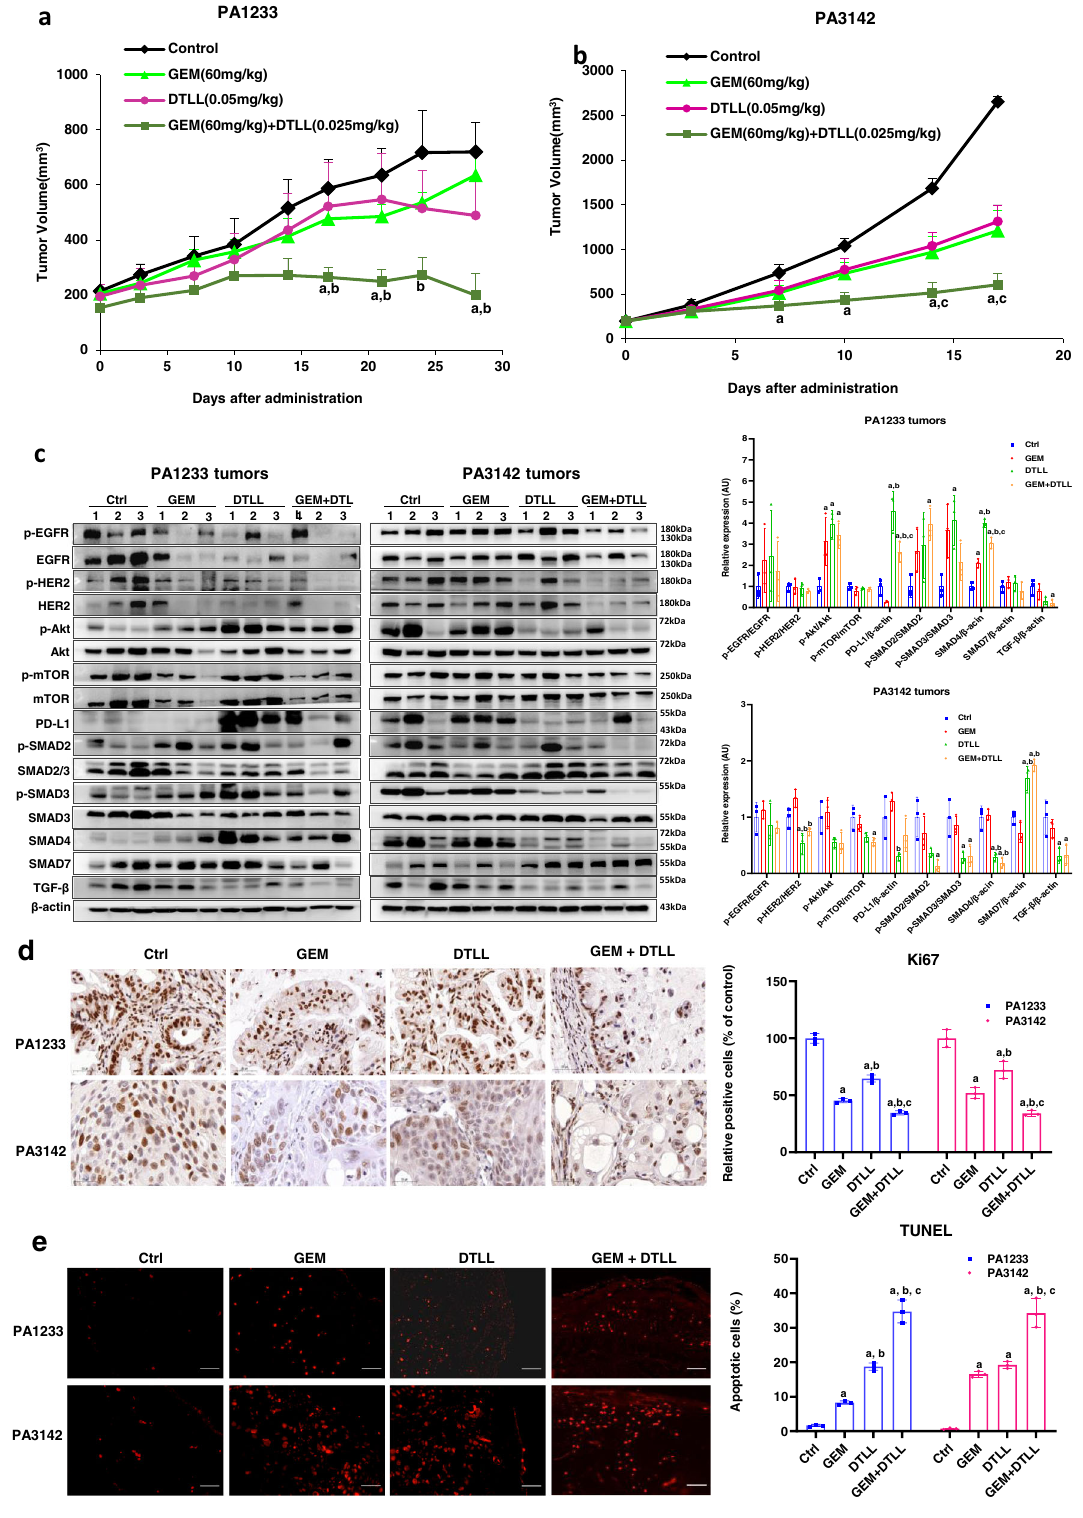
for validating their basic expression pro fi les in the BxPC3-EV, -WT and -Mut cells (Fig. S4).